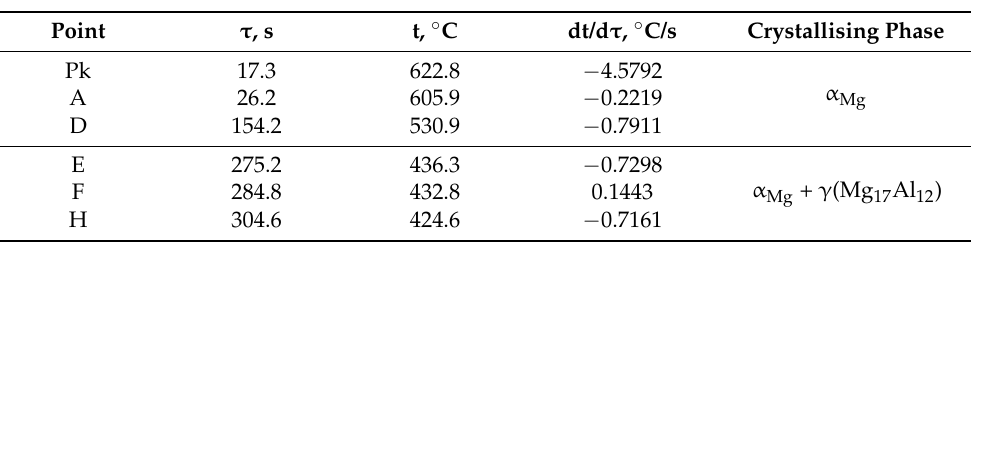
Table 4. Characteristic DTA points of modified magnesium alloy AZ91 with 0.3 wt % of Zr.